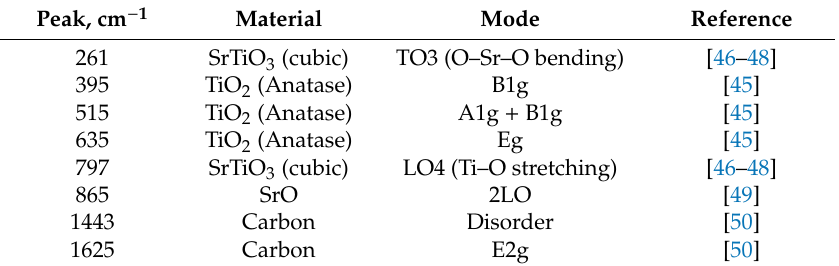
Figure 4. Raman shift spectra of Si/TiO x /Pt/SrTiO 3 /Ni heterostructure. Table 1. Raman spectra bands. Table 1. Raman spectra bands.